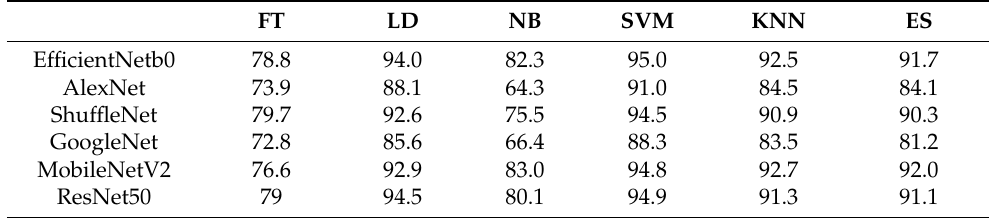
Table 3. Accuracy of Pre-trained Models+ SVM + Classifiers (%).